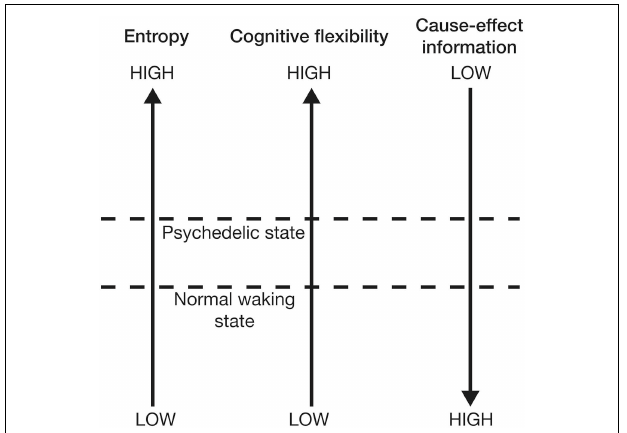
FIGURE 7 | Increasing neural entropy elevates cognitive flexibility at the expense of a decrease in the cause-effect information specified by individual mechanisms.